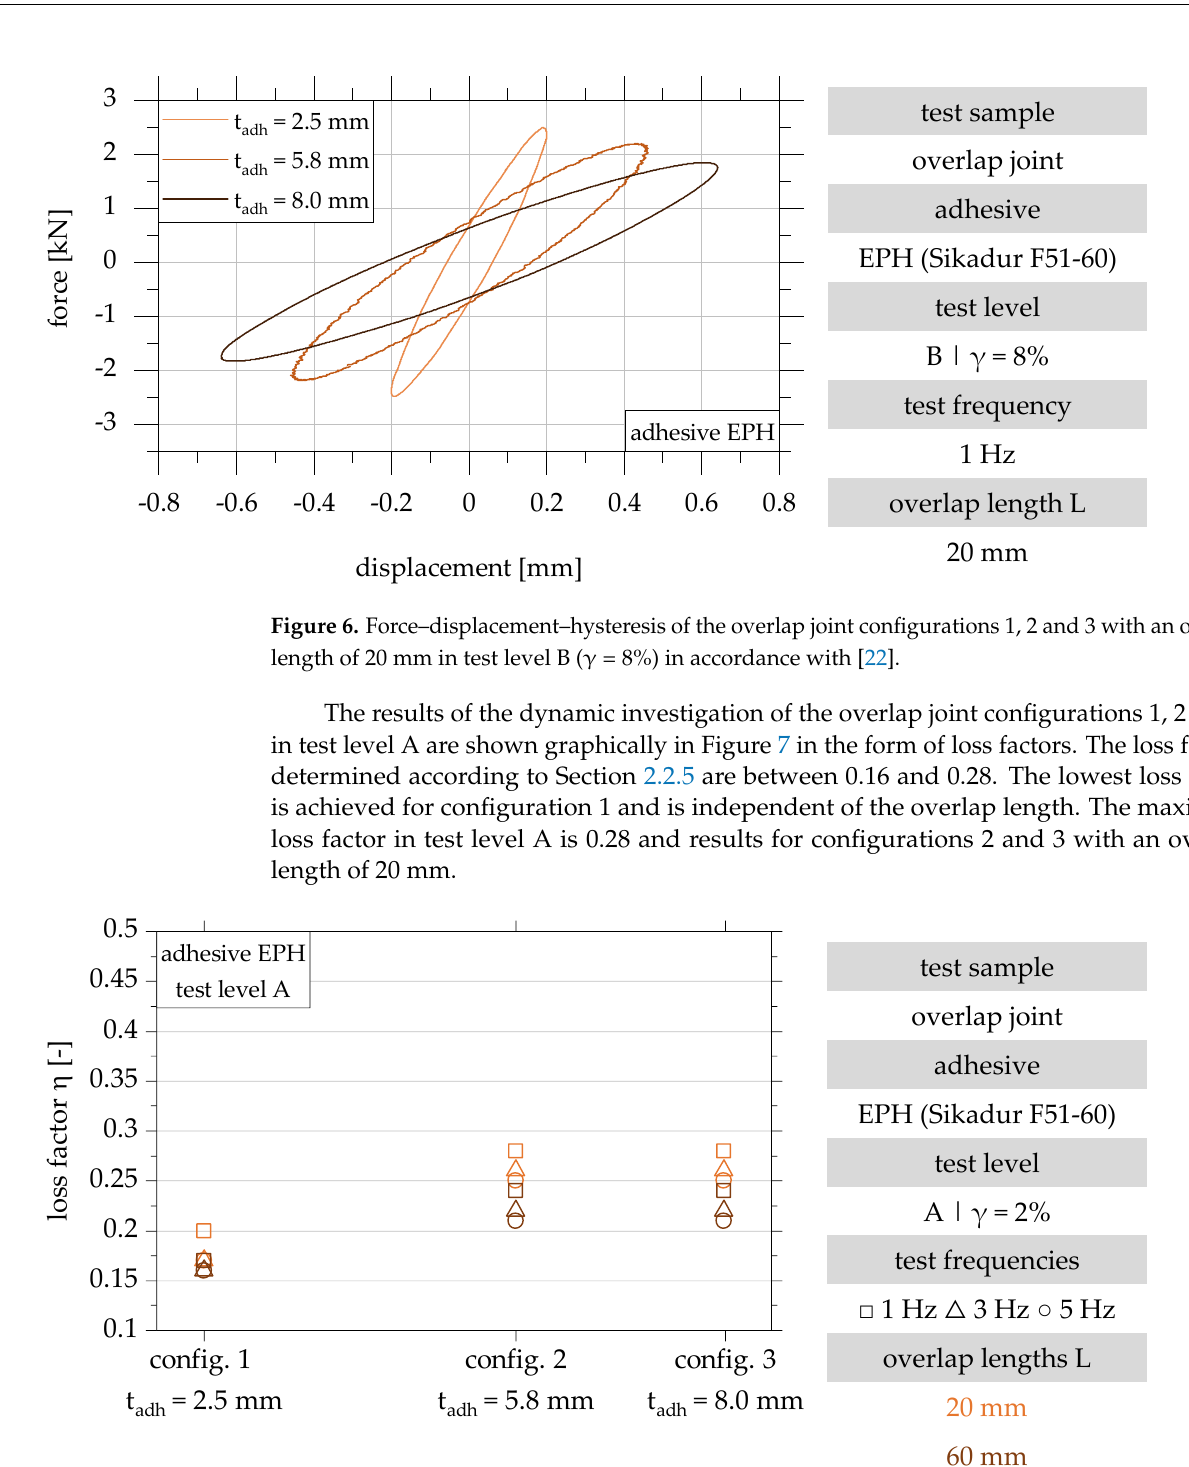
10 of 23 The shear stress–shear strain curves of the overlap joints bonded with the adhesive EPH show that the initial stiffnesses are approximately identical up to a shear strain of 1.5% for all specimen geometries considered. For the adhesive EPH, a significant deviation of the curves depending on the specimen geometry can be observed from a value of the shear strain of approx. 2% to 2.5%. From a shear strain of 3%, the curves flatten and then continue with a lower slope. Two test levels, A and B, are derived on the basis of the previously shown shear stress–strain curves, which can be characterised as follows: • Test level A: γ ± 2%, range of approx. linear initial stiffness and linear viscoelastic behaviour, low influence of non-linear material behavior, • Test level B: γ ± 8%, end of the range of linear initial stiffness, decreasing joint stiff- ness depending on the adhesive layer geometry, the influence of non-linear material behavior. 3.2. Damping Properties of Overlap Joints Bonded with an Epoxy–Resin-Hybrid-Based 2- Component Adhesive